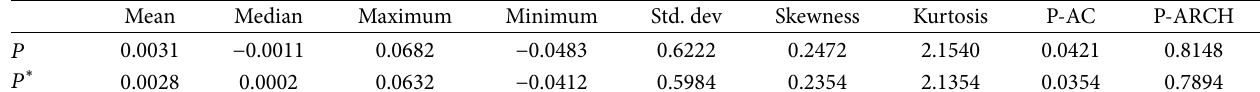
Table 2: Descriptive statistics.